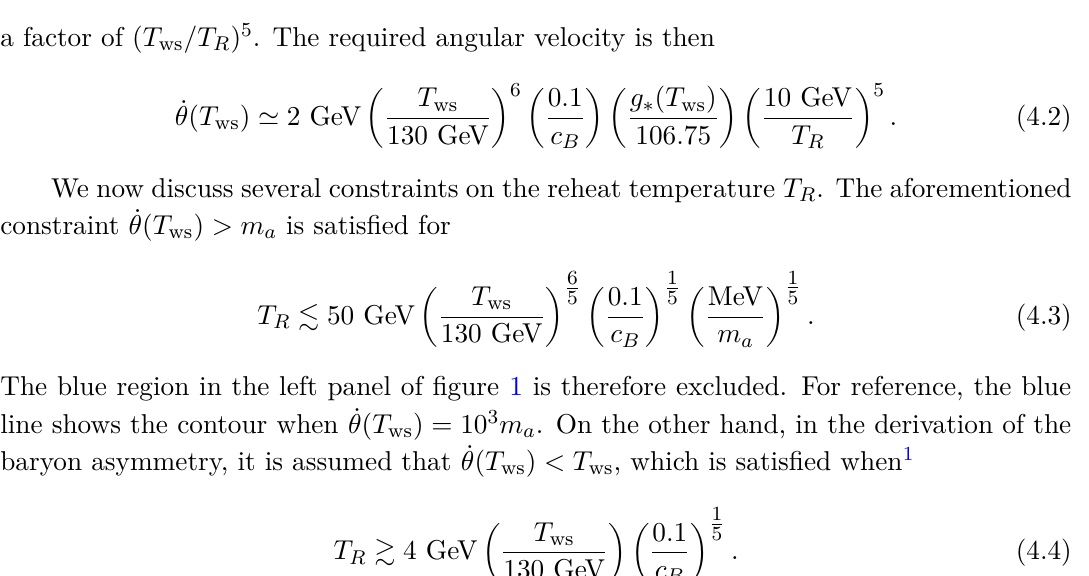
Figure 1 . Left: individual constraints that determine the viable parameter space in the right panel are explicitly shown with the reheat temperature T R as a free parameter. Right: the brown hatched region shows the viable parameter space where the baryon asymmetry can be explained by axiogenesis with a heavy QCD axion, specifically for the case where the axion mass is a constant after the electroweak phase